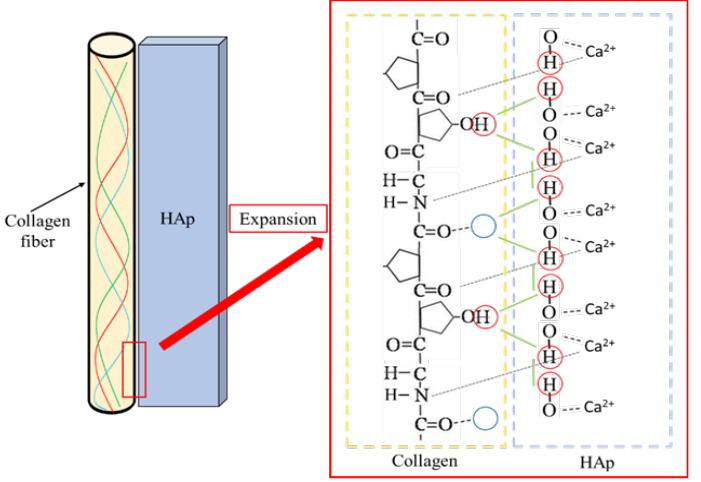
Figure 10. Proton-conductivity pathway in the HAp-collagen composite.